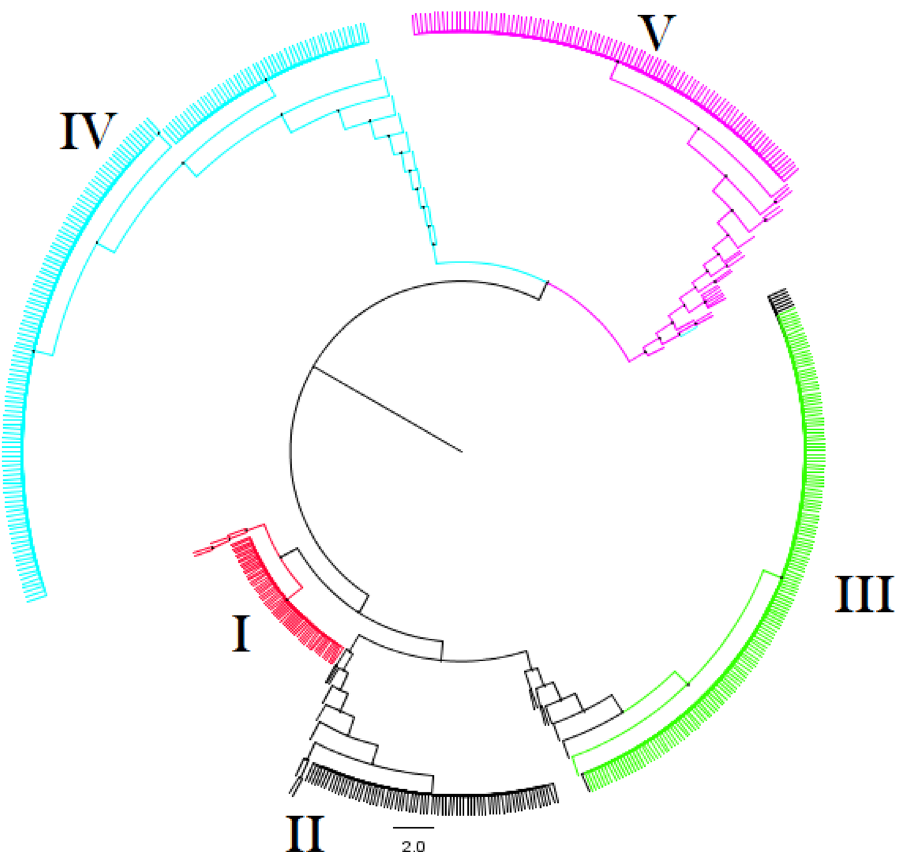
Figure 3. The phylogenetic tree constructed using the Neighbor-Joining method based on 625 rice accessions representing O. barthii (88 samples), O. glaberrima (169), O. longistaminata (69), O. sativa spp. indica (178) and O. sativa spp. japonica (121), plotted with 36 KASP SNPs diagnostic markers. Details about the 625 rice accessions were provided in the Supplementary Table S2. The colors in the tree correspond to subpopulations. Cluster I in red represents O. longistaminata accessions, cluster II in black represents O. barthii accessions, cluster III in green represents African rice O. glaberrima accessions, cluster IV in blue represents Asian rice O. sativa spp indica accessions, and cluster V in pink represents Asian rice O. sativa spp